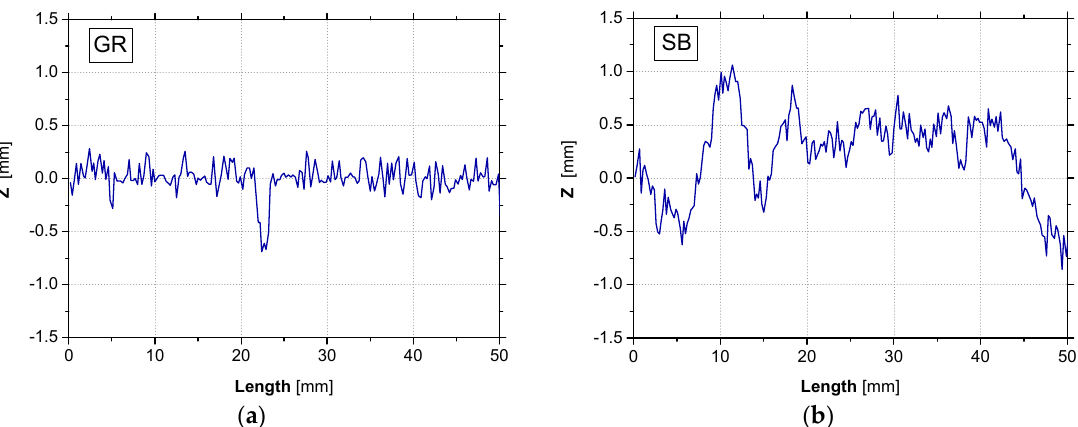
Figure 3. Roughness profile when different surface preparation methods were applied: ( a ) grinding; ( b ) sandblasting.